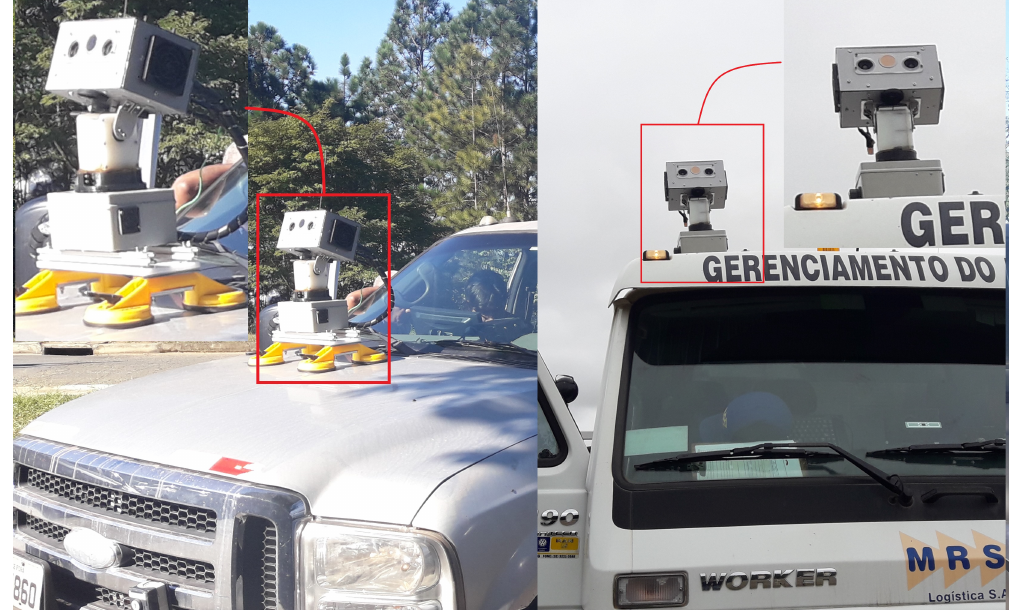
Figure 8. Robot assemble in two different configurations and inspection vehicles.